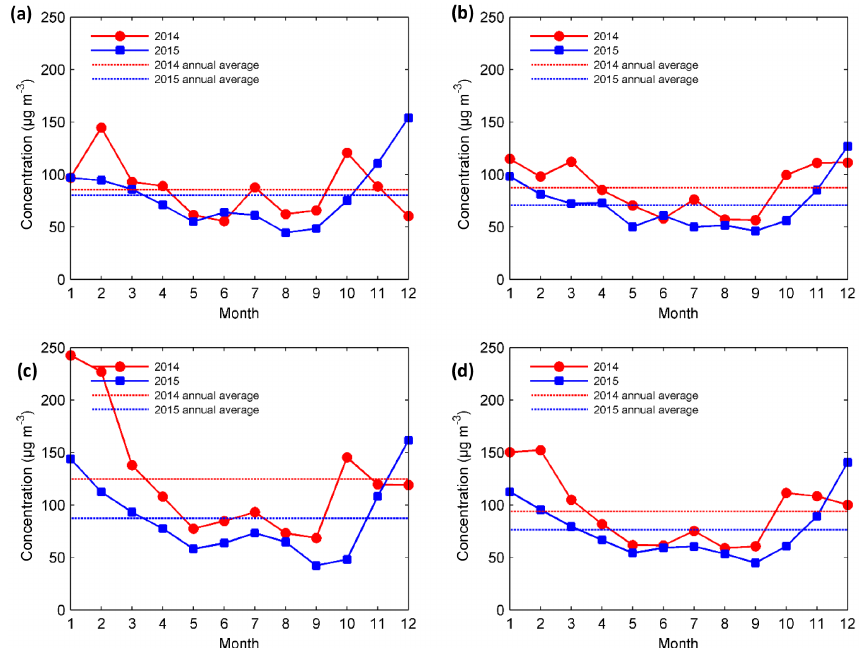
Figure 2. Comparison of monthly average PM 2 . 5 concentrations in 2015 and 2014 in (a) Beijing, (b) Tianjin, (c) Shijiazhuang, and (d) the Jing-Jin-Ji